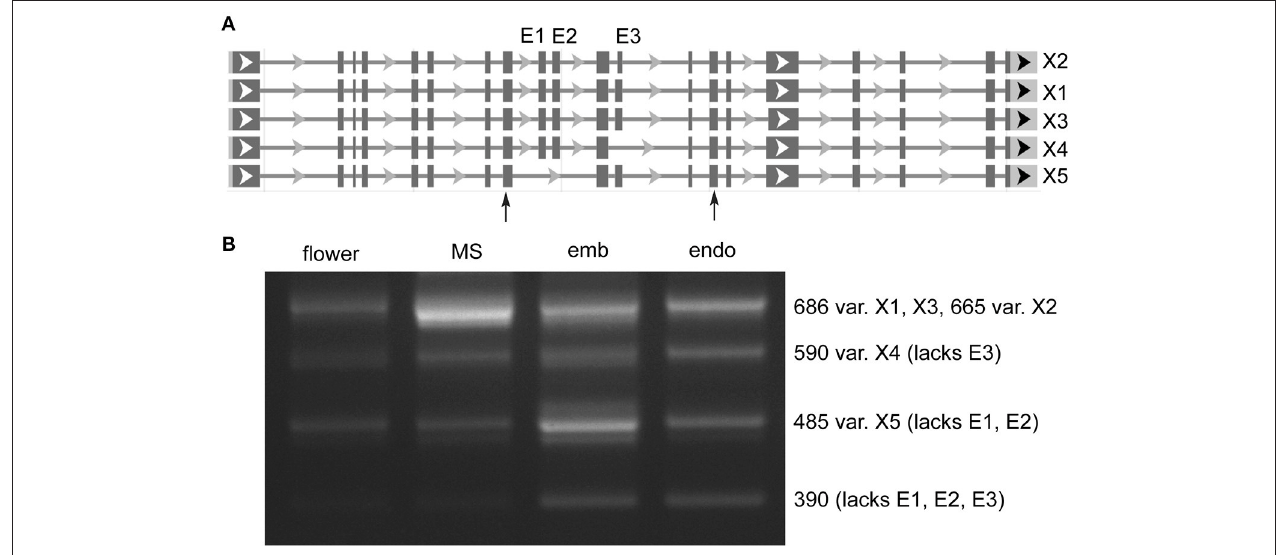
FIGURE 2 | Alternative splicing of MORC7 (LOC4329338) skipped exons in milk seed, embryo, and endosperm. (A) Gene structure. Primers flanking skipped exons are indicated by arrows. (B) RT-PCR analysis of splice variants (MS, milk seed; emb, embryo; endo, endosperm). Three exons are predicted. An unannotated variant lacking all three exons is also present in developing